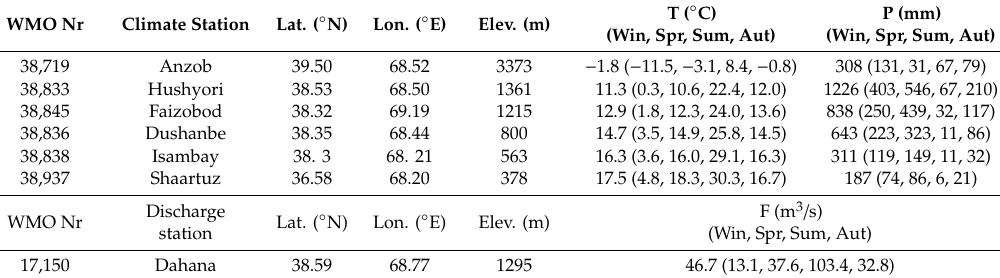
Table 1. Location of the climate station under study with coordinates and the monthly mean of air temperature (T), precipitation (P), and streamflow (F)—totals for each season during the 1951–2012 period. WMO Nr Climate Station Lat. ( ◦ N) Lon. ( ◦ E) Elev.